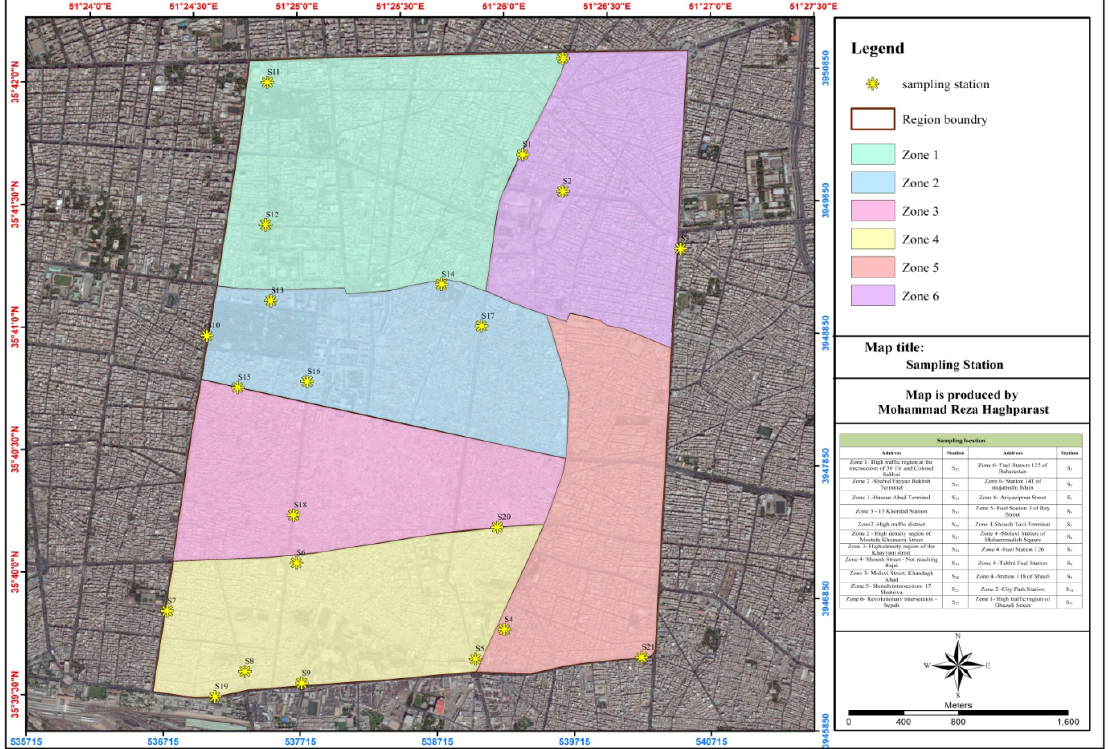
Figure 1. The locations of 22 Sampling point in 6 zones Table 1. Location of 22 sampling for air pollutants on January, 2018 Station No. Sampling locations Station